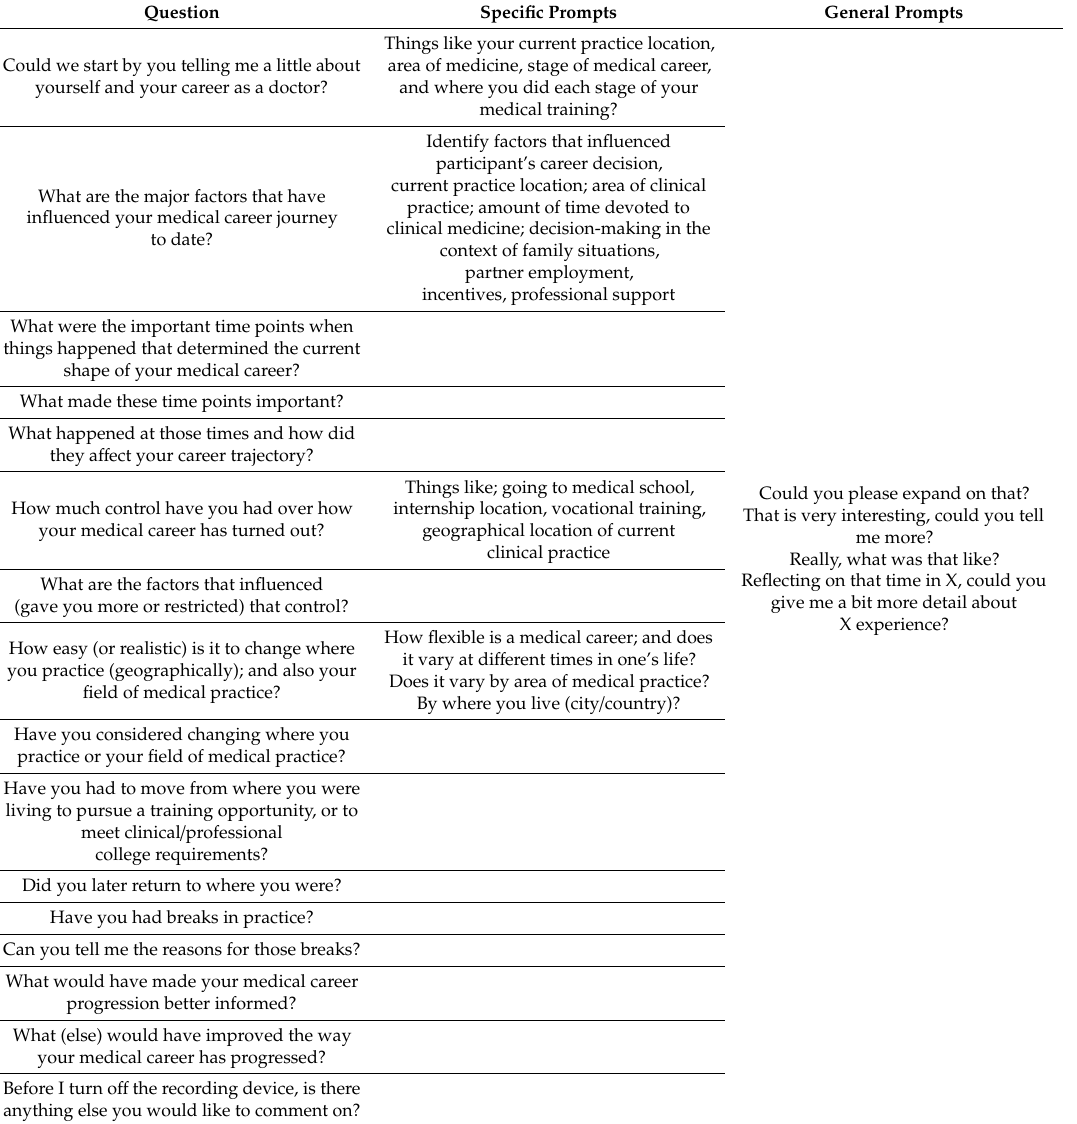
Table 1. Interview guide used in phase